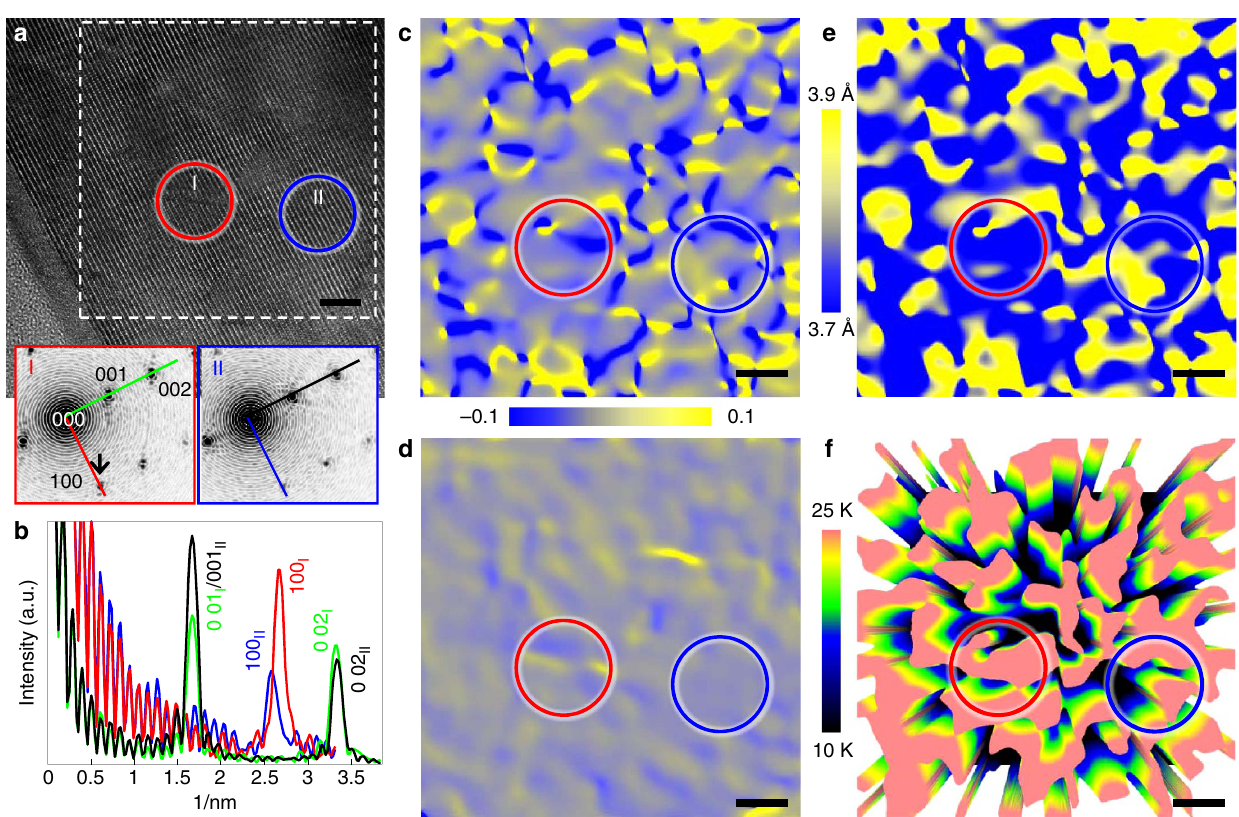
Figure 3 | Strain analysis in a 190keV proton irradiated FST film. ( a ) HRTEM image. The inset I and II are the diffractogram from the circled area I (red) and II (blue), respectively. ( b ) Intensity line profiles of 001/002 (green and black) and 100 (red and blue) spots from the scan lines shown in the inset I and II of a . ( c , d ) Strain maps of in-plane e xx ( c ) and out-of-plane e zz ( d ) calculated by geometrical phase analysis (GPA) 53–55 from the square area outlined by dash line in a . The colour bar in the middle indicates the strain from (cid:3) 0.1 (compressive) to 0.1 (tensile). ( e ) Map of in-plane lattice parameter determined from the GPA map in c . The colour bar in the left indicates the change in lattice parameter from 3.7 to 3.9Å. ( f ) Perspective view of the spatial distribution of T c calculated from the local strain (Supplementary Fig. 3). The red and blue circles show the same area. Scale bar, 5nm ( a , c – f